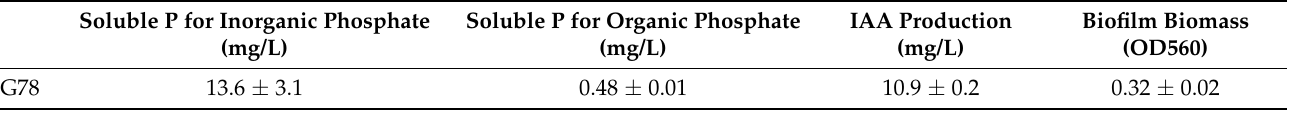
Table 1. Plant growth-promoting traits of P. mucilaginosus G78 strain. Soluble P for Inorganic Phosphate